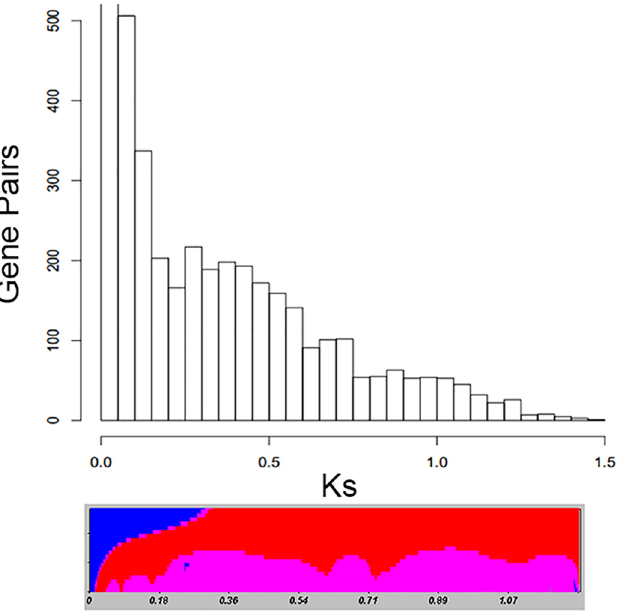
Fig 4. Histogram of KS values. A histogram of KS values with significant peaks identified in a SiZer graph below. Blue represents increases in slope; red indicates decreases; pink areas have no significant slope changes. A sharp increase at a KS (cid:3) 0.22 is indicated by a blue dot. This increase is followed by a broad pink peak of no changes with a decrease beginning at a KS of 0.60. Additional sharp declines are identified at KS of 0.71 and